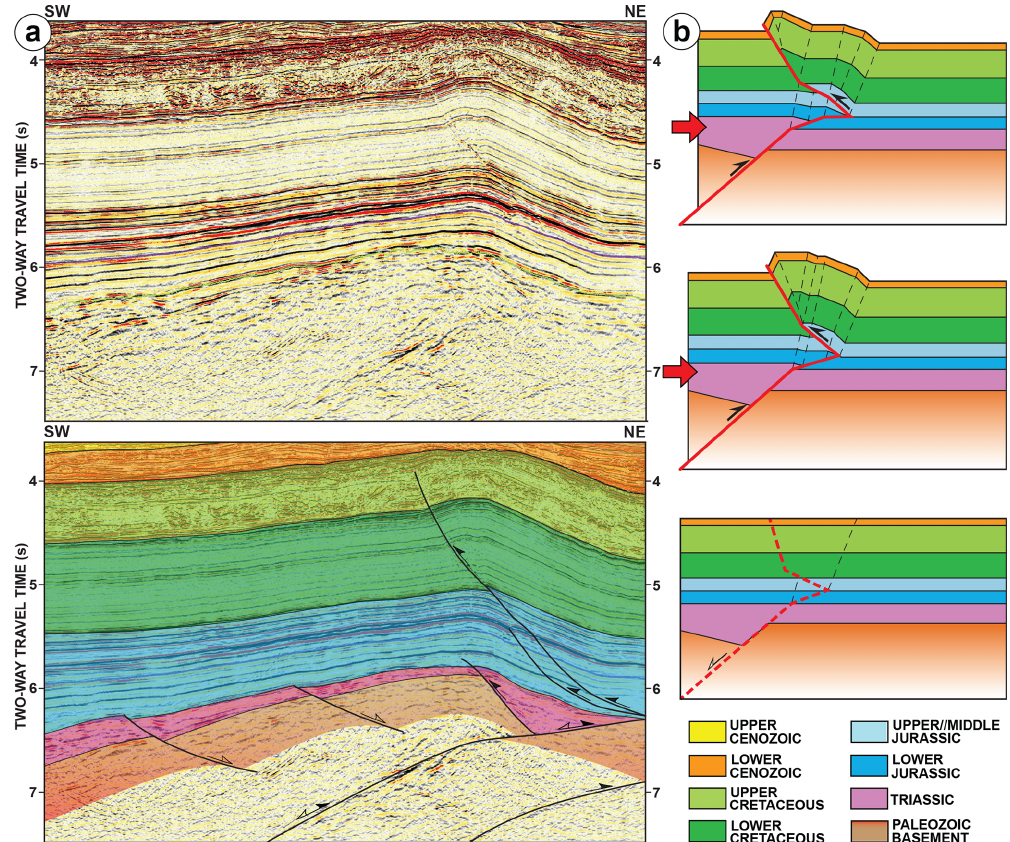
Figure 14. (a) Dip-directed 3D seismic reflection seismic line across one of the inversion anticlines in deepwater Morocco; for location, see Figs. 12b and 13b. The formation of a basement-involved inversion fold adapted and slightly modified from McClay et al. (2019). This structural model is the explanation for the somewhat unusual inversion geometry for some of the deepwater anticlines in the Ras Tafelney Plateau area, offshore Morocco (Fig.